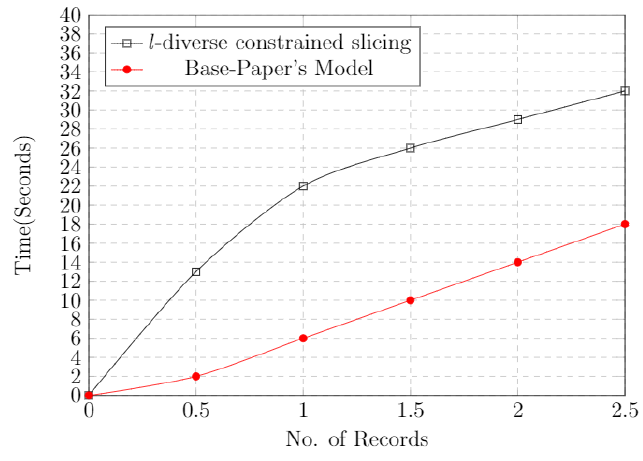
Figure 8. Time cost graph and comparison with base paper